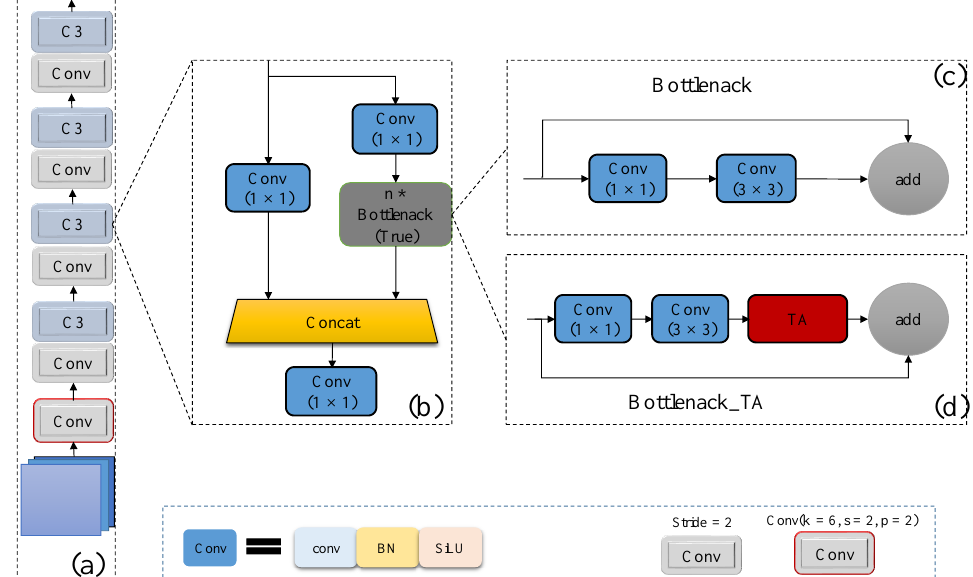
Figure 5. Illustration of the backbone with triplet attention. ( a ) Structure of backbone; ( b ) C3 module with residual structure; ( c ) Detailed structure of residual blocks in YOLOv5; ( d ) Proposed Bottleneck_TA module with triplet attention. * stands for repeating the